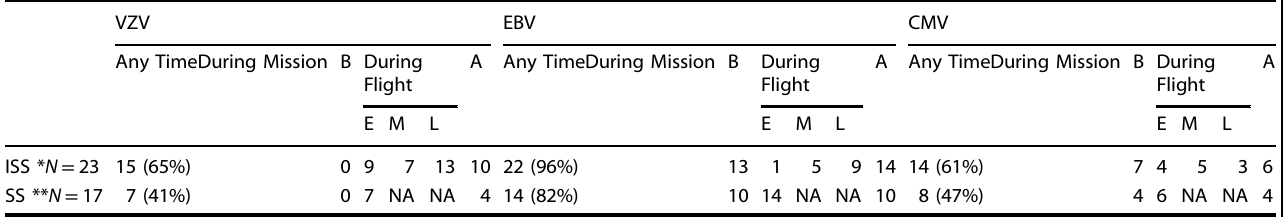
Table 2. Number of crewmembers shedding viruses in their saliva before, during and after International Space Station and Space Shuttle missions VZV EBV